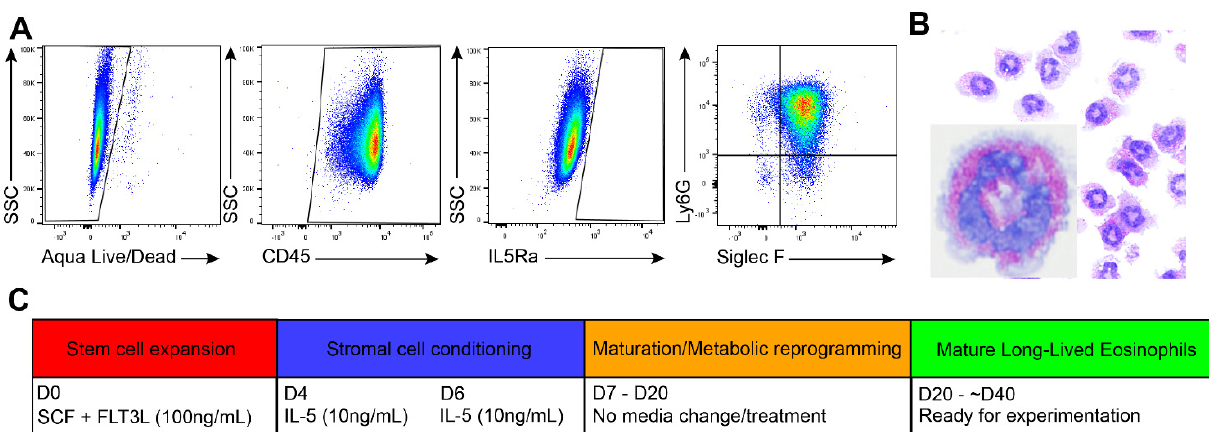
Figure 1. Protocol for bone marrow-derived culture of long-lived murine eosinophils (llEos). ( A ) llEos gating strategy. At maturity (culture Day 20), these cells are CD45(+), IL-5R α ( − ), Siglec-F(+) and Ly6G(+). Representative flow cytometry plots are shown. ( B ) llEos are highly granulocytic, and granules stain eosin red by Diff-Quik staining. Representative image of an individual cell taken at 100 × magnification. ( C ) Timeline of llEos culture. SCF = stem cell factor, FLT3L = Flt-3 ligand, IL-5 = interleukin 5.